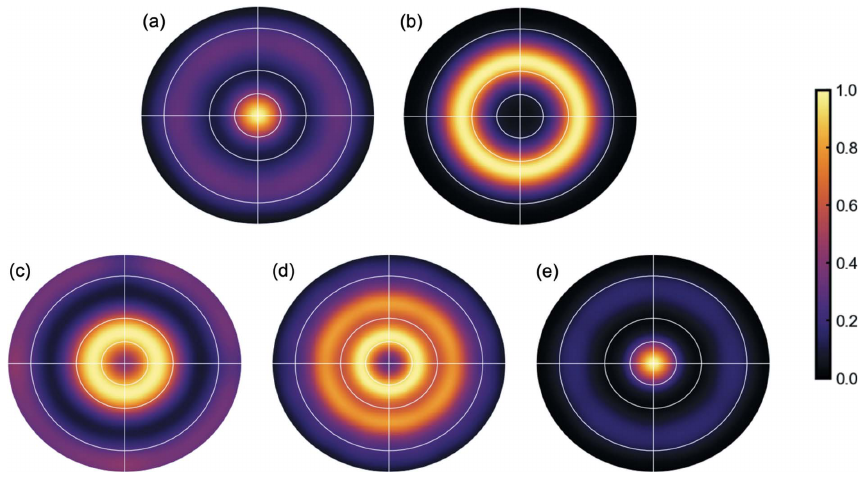
Figure 6 Reciprocal-space pole figures derived from the scattering volume S ( Q ). Peaks: ( a ) {111}, ( b ) {002}, ( c ) {022}, ( d ) {133} and ( e )